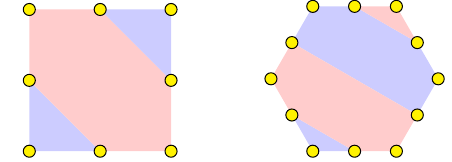
FIG. 23. Gauge fixings of a square (left) and hexagonal (right) face of a subsystem toric and f 6 ; 4 g subsystem hyperbolic code, respectively. Yellow-filled circles are data qubits, and X and Z stabilizers are denoted by red- and blue-filled polygons, respec-